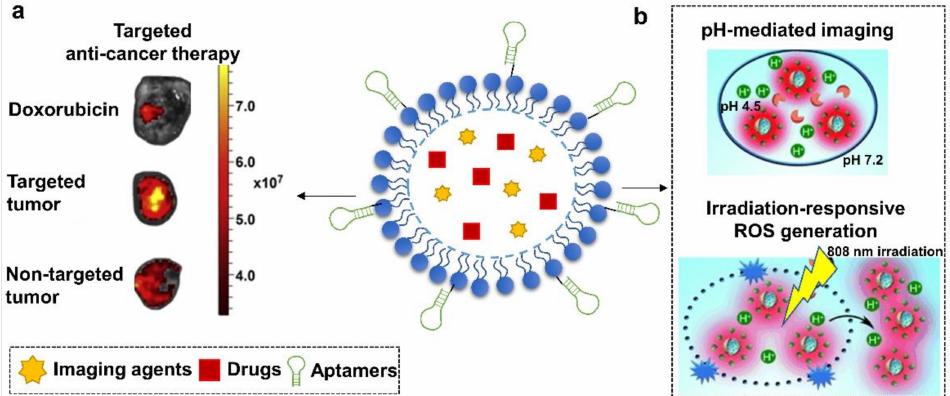
Figure 4. Schematic illustration of aptamer-functionalized micelles. They have been used to, ( a ) specifically deliver DOX to WR22R ν 1 tumor-bearing mice for anti-prostate cancer therapy and ( b ) mediate pH/NIR-responsive breast cancer-specific imaging and therapy. ( a ) is modified with permis- sion from reference [98]. Copyright 2013 Elsevier. ( b ) is adapted from reference [102]. Copyright 2014 Wiley Online